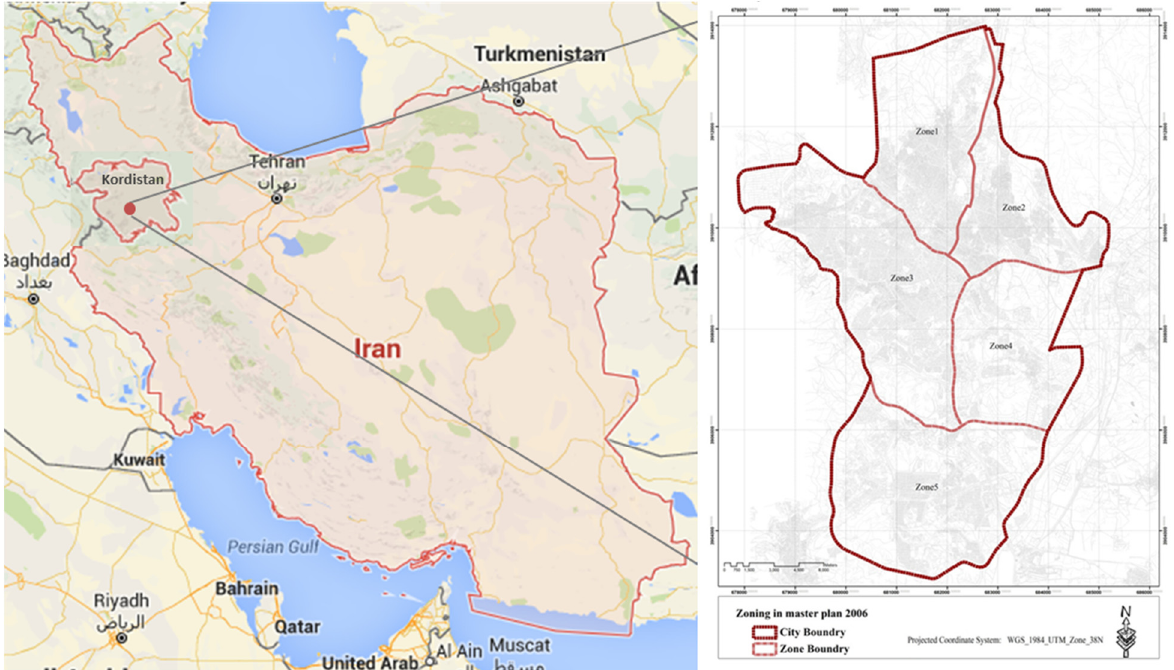
Figure 1. The situation of Sanandaj city in Iran.